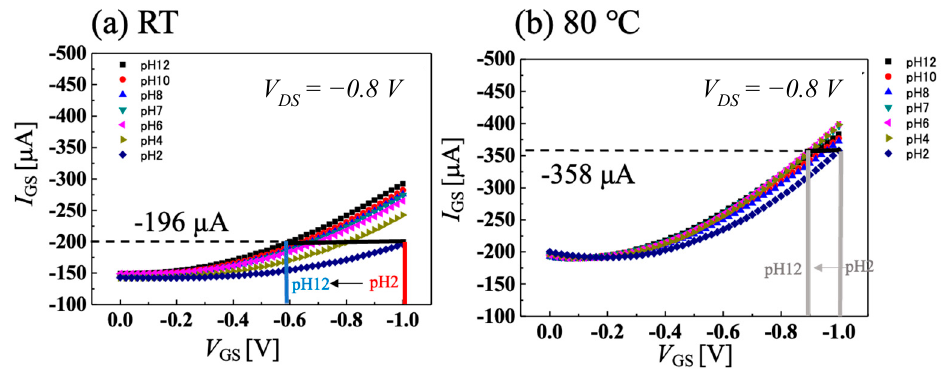
Figure 4. pH measurement using Ag/AgCl electrode at V DS = − 0.8 V when solution temperature is ( a ) room temperature and ( b ) 80 °C.